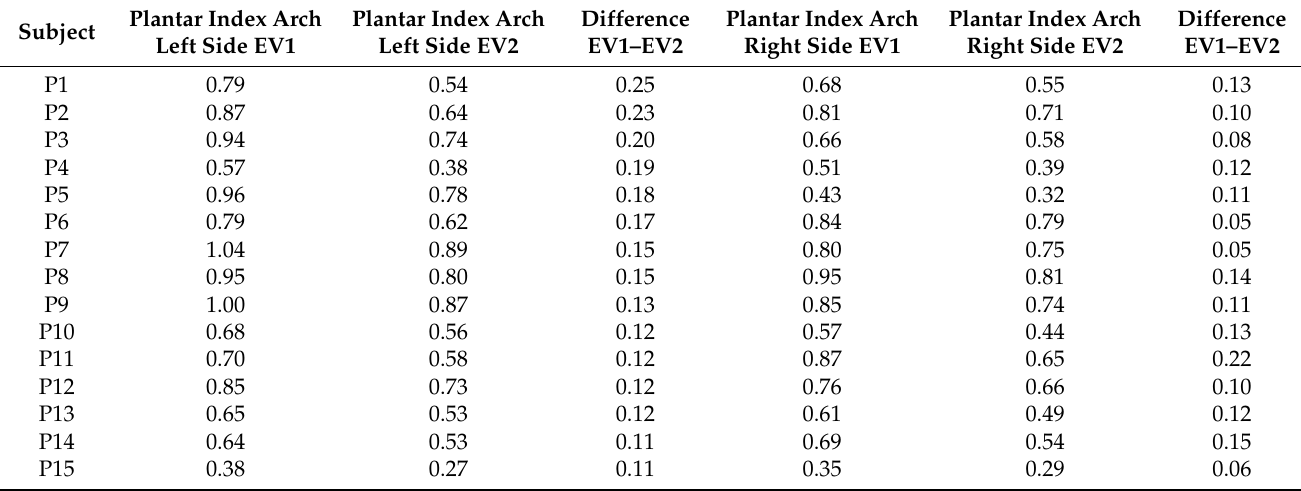
Table 4. Plantar index arch evolution (Group 2, n =